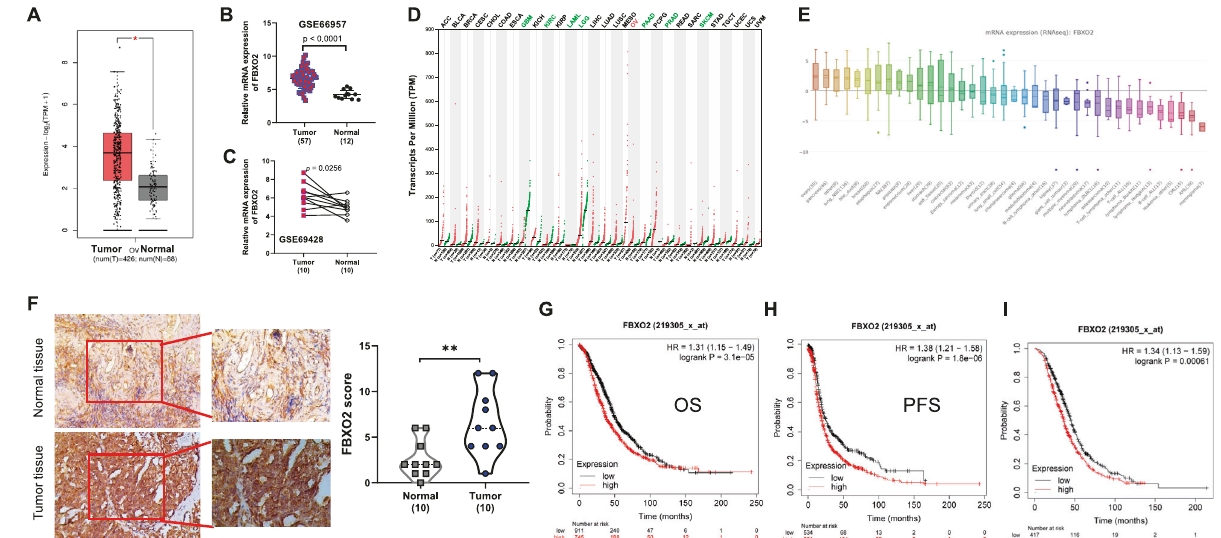
Fig. 1 Upregulation of FBXO2 correlates with poor prognosis for OV patients. A The mRNA expression of FBXO2 in TCGA OV and GTEx datasets through the GEPIA website (http://gepia2.cancer-pku.cn/). Red represents OV tissue and black represents normal tissue. B Relative mRNA expression of FBXO2 in GSE66957 dataset. Red represents OV tissue and black represents normal tissue. C Relative mRNA expression of FBXO2 in GSE66428 dataset. D Dot plot showed FBXO2 gene expression pro fi le in 29 tumor types and matched normal tissues from TCGA and GTEx datasets. Each point represents the expression of the sample. E The mRNA expression of FBXO2 in cell lines from different cancer types obtained through the CCLE website (https://sites.broadinstitute.org/ccle). F The representative IHC staining images (scale bars, 100 μ m) and the expression scores of FBXO2 in normal ovarian tissues and OV tissues from 10 OV patients. G , H . The overall survival (OS) ( G ), the progression-free survival (PFS) ( H ), and the post-progression survival (PPS) ( I ) curves of FBXO2 were plotted for all OV patients in the Kaplan – Meier Plotter database